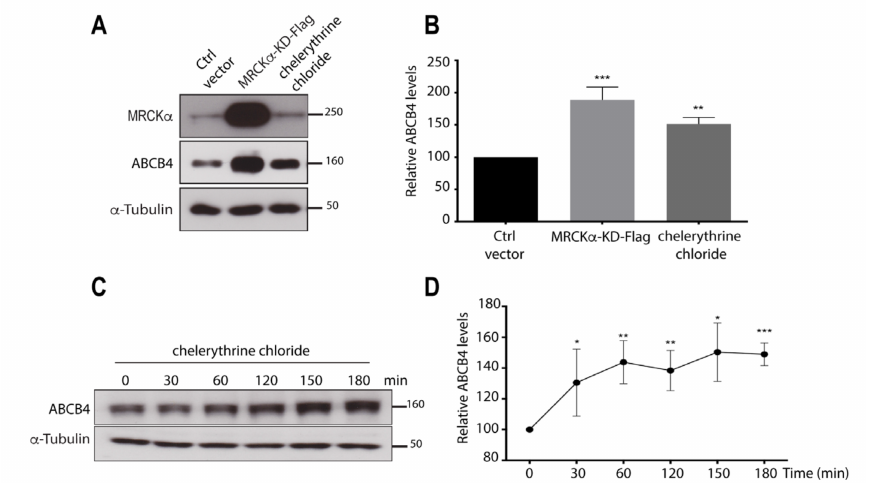
Figure 3. Effect of inhibition of MRCK α kinase activity on ABCB4 protein expression. ( A ) HEK-293 cells stably expressing ABCB4 were either transfected with the empty vector-Flag (ctrl vector) or Flag-tagged MRCK α -kinase-dead (MRCK α -KD-Flag) or treated with 10 mM of chelerythrine chloride for 2 h. Cells were then lysed and analyzed by immunoblotting using anti-MRCK α , anti-ABCB4, and anti-a-tubulin antibodies. ( B ) Amounts of ABCB4 were quantified from immunoblots by densitometry. ABCB4 levels were expressed as a percentage of total expression in HEK-293 cells transfected with ctrl vector. Means ( ± SEM) of at least eight independent experiments are shown. *** p < 0.001; ** p < 0.01. ( C ) Primary human hepatocytes were treated with 20 mM of chelerythrine chloride for the indicated time points. Cells were then lysed and analyzed by immunoblotting using anti-ABCB4 and anti-a- tubulin antibodies. Presented data were cropped from the full immunoblots shown in Supplementary Figure S3. ( D ) Amounts of ABCB4 were quantified from immunoblots by densitometry. ABCB4 levels were expressed as a percentage of total expression of untreated (Time 0 min) hepatocytes. Means ( ± SD) of at least three independent experiments are shown. *** p < 0.001; ** p < 0.01; * p <